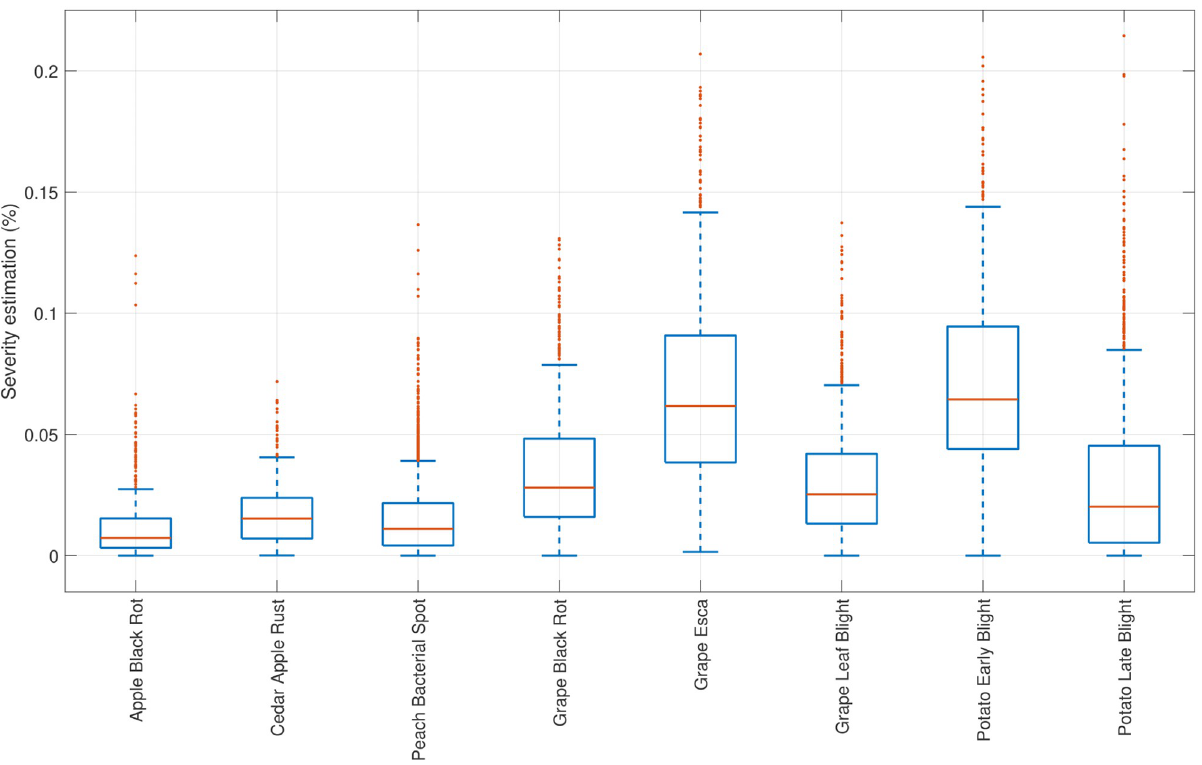
Fig 8. Disease severity statistical analysis through the boxplot of data results from each disease dataset.